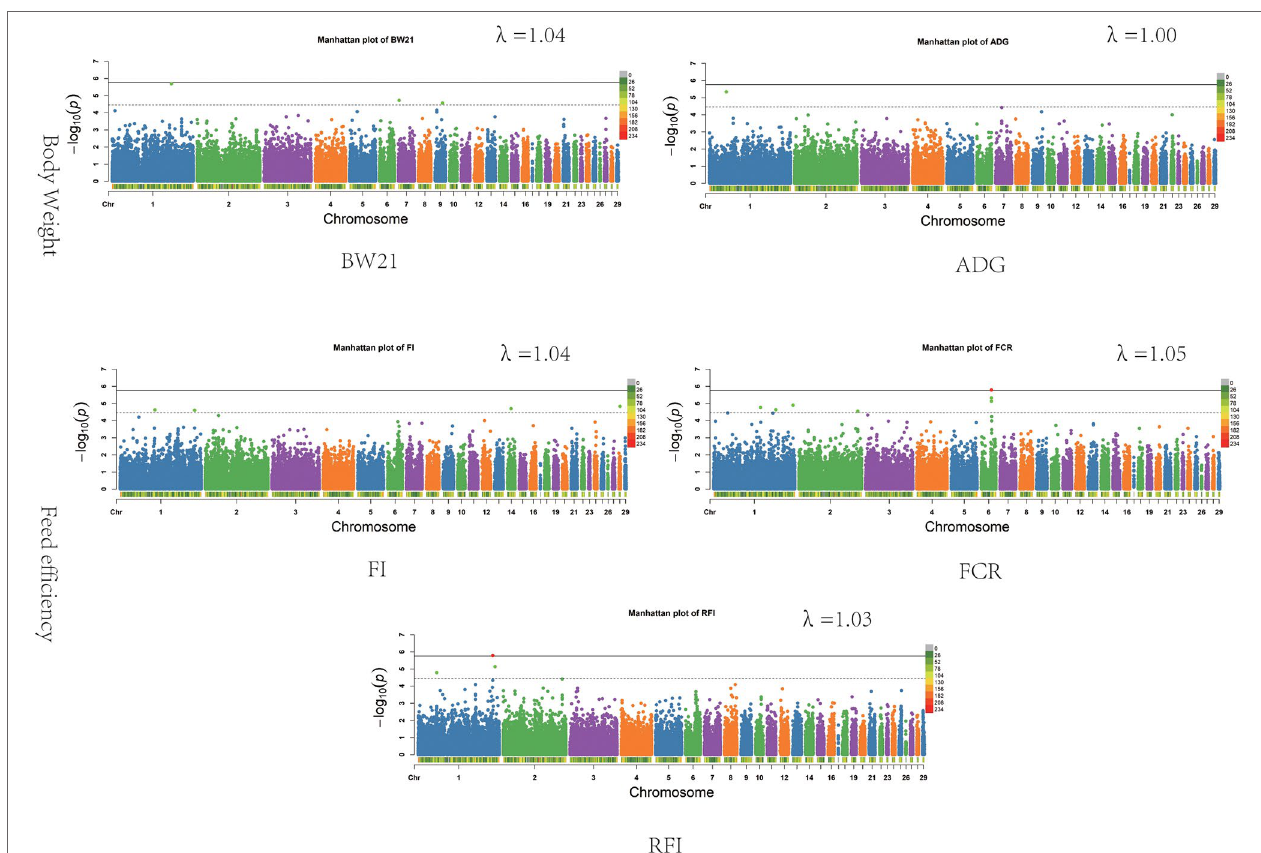
FIGURE 1 | Associations of SNPs for all traits. In Manhattan plots, SNPs are plotted on the x -axis according to their position on each chromosome, against association with these traits on the y -axis (shown as −log10 P -value). Dashed line indicates suggestive significance association level ( P = 3.48E−05), and solid line shows genome-wide significance with a P -value threshold of 1.74E−06. The colour of points with suggestive significance are green while points of genome-wide significance are red. The heatmap represents density of SNPs in 1 Mb windows. The estimated genomic inflation factor λ ranged from 1.03 to